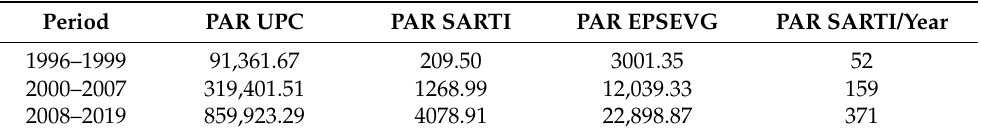
Table 13. PAR points: UPC, SARTI, and School for the period 1996–2019. Period PAR UPC PAR SARTI PAR EPSEVG PAR SARTI/Year 1996–1999 91,361.67 209.50 3001.35